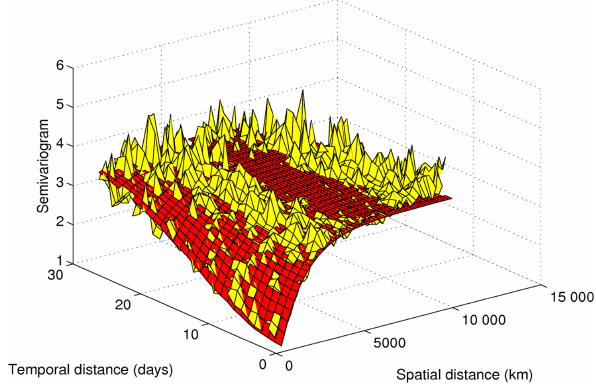
Figure 2. Illustration of the experimental and fitted theoretical spatio-temporal variogram for GOSAT XCO 2 data.